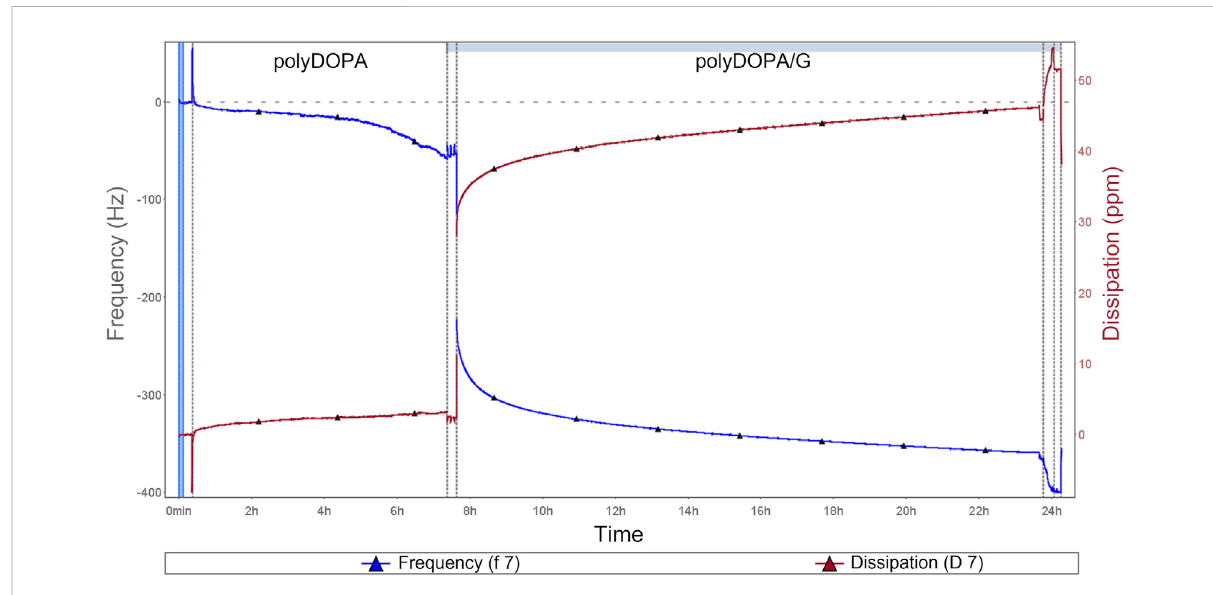
FIGURE 2 QCM-D analysis during polyDOPA/G deposition: blue curve refers to frequency, while red curve represents dissipation as a function of incubation time. All the phases of functionalization are displayed, including initial sensor preconditioning as well as washing steps after polyDOPA coating before G